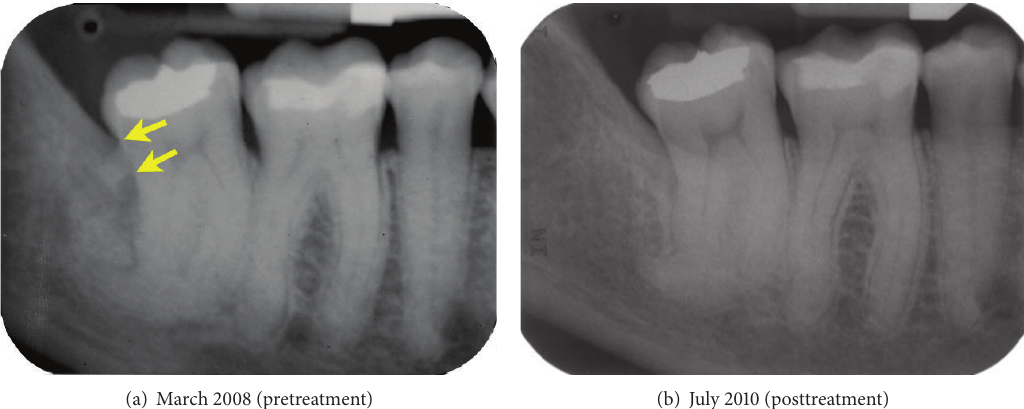
Figure 1: Periapical radiographs of the mandibular right posterior teeth. Radiograph (a) was obtained one month prior to the patient’s initial consultation appointment. Arrows indicate the apical and occlusal borders of the calculus deposit. Radiograph (b) was obtained two years after completion of active periodontal